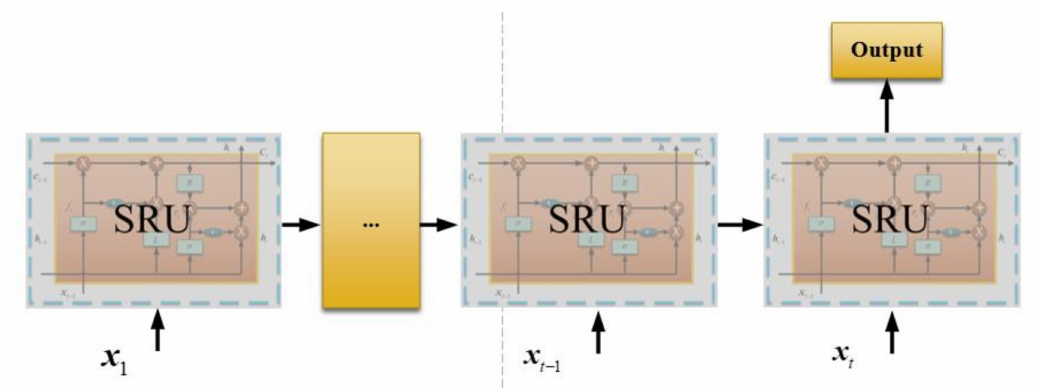
Figure 3. Basic structure of Deep Simple Recurrent Unit–Recurrent Neural Networks